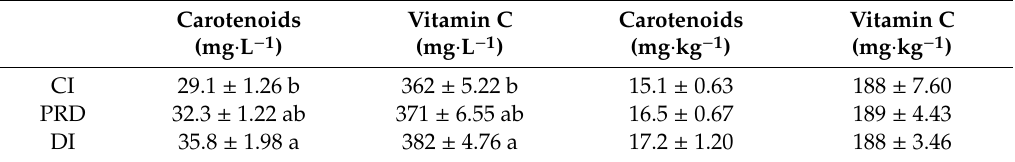
Table 1. Total carotenoids and vitamin C in juice and fruits of adult ‘Valencia’ orange trees under conventional irrigation (CI), partial rootzone drying (PRD), and continuous deficit irrigation (DI). Measurements taken only in fruits harvested in 2010. When present, lower-case letters indicate significant di ff erences among irrigation treatments and within each column (Tukey’s multiple range test, p <